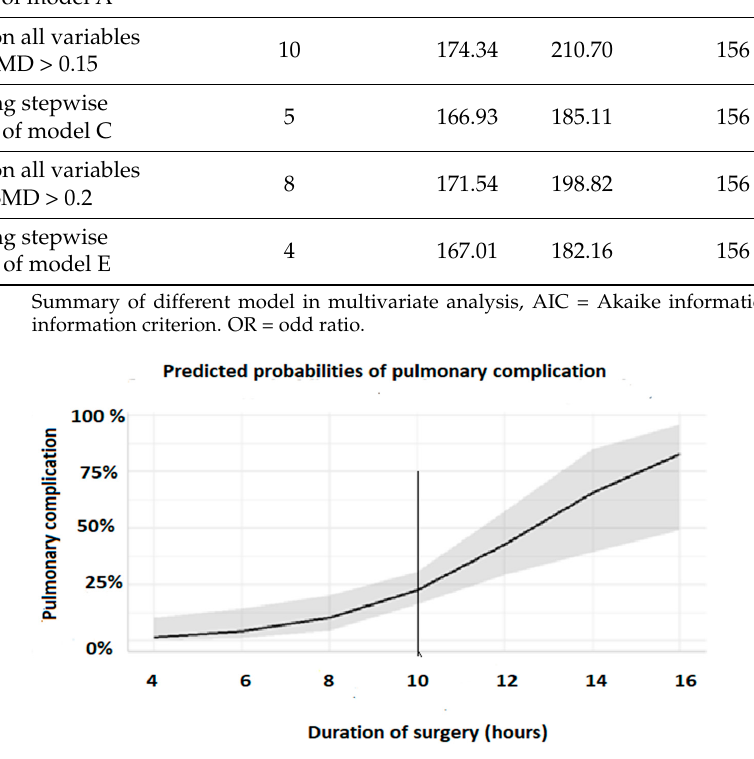
Figure 2. Impact of duration of surgery on pulmonary complications. After 10 h of surgery (cut off line) the probability of pulmonary complication significantly increased.